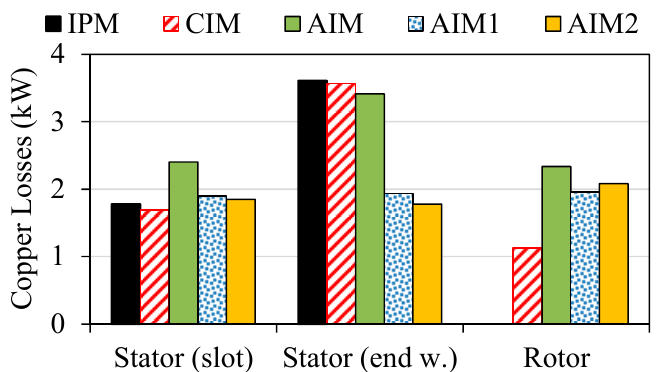
Figure 13. Comparison of copper losses including stator in-slot winding, stator end-windings, and rotor bars.